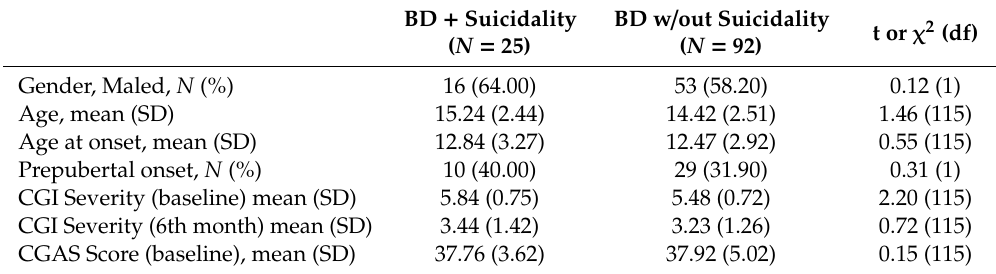
Table 5. Comparisons between patients with ( N = 25) and without suicidality ( N =